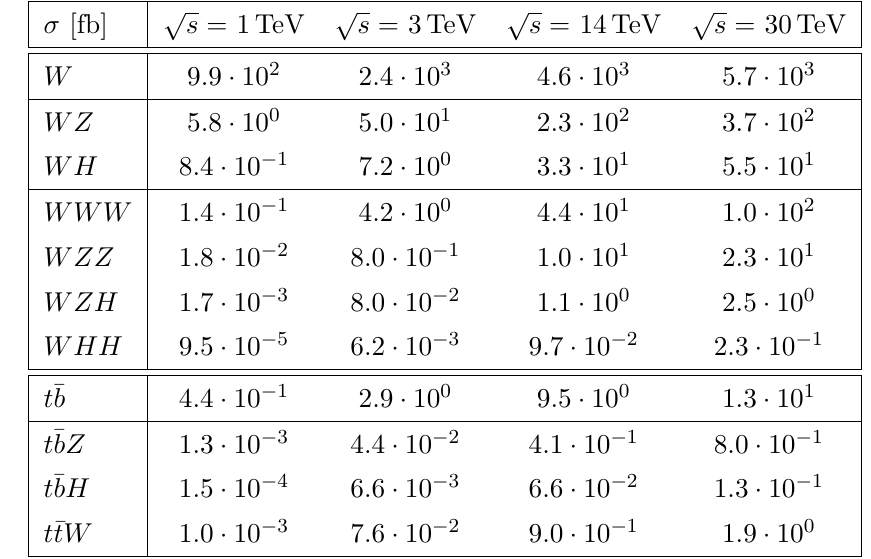
Table 4 . Same as table 3 but for WZ=W(cid:13)